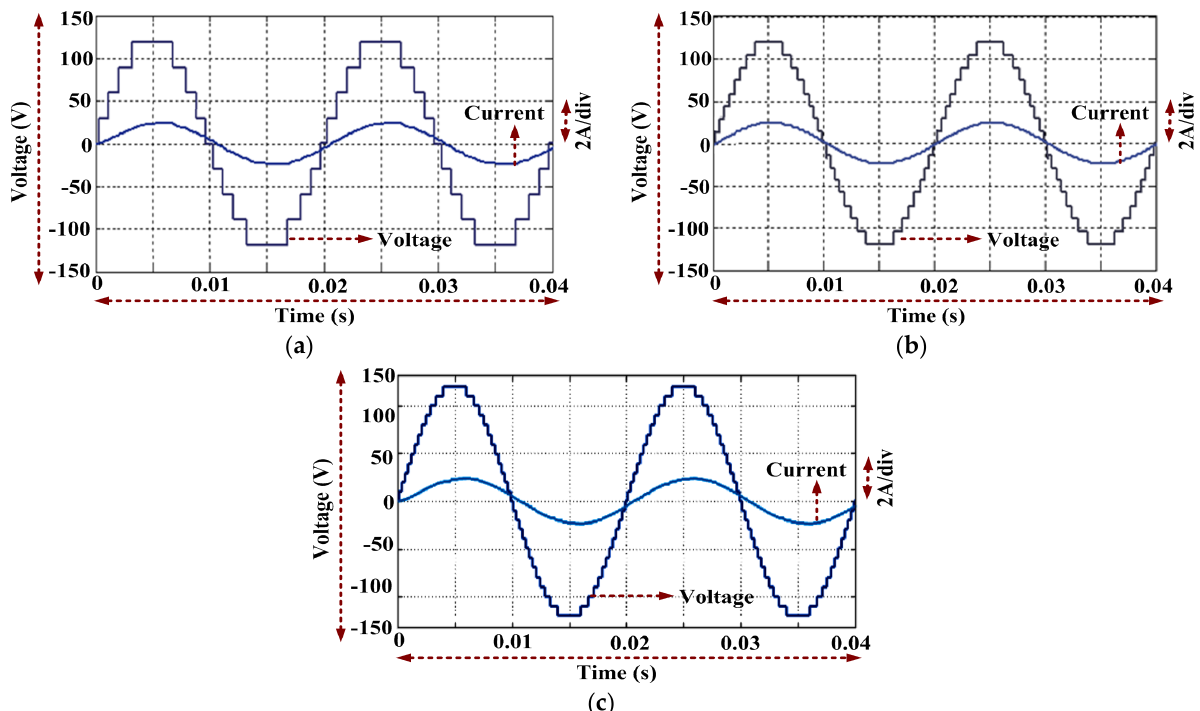
Energies 2021 , 14 , x FOR PEER REVIEW Figure 9. Simulation output voltage and current waveform results ( a ) 9-Level, ( b ) 17-Level, ( c ) 25-Level.